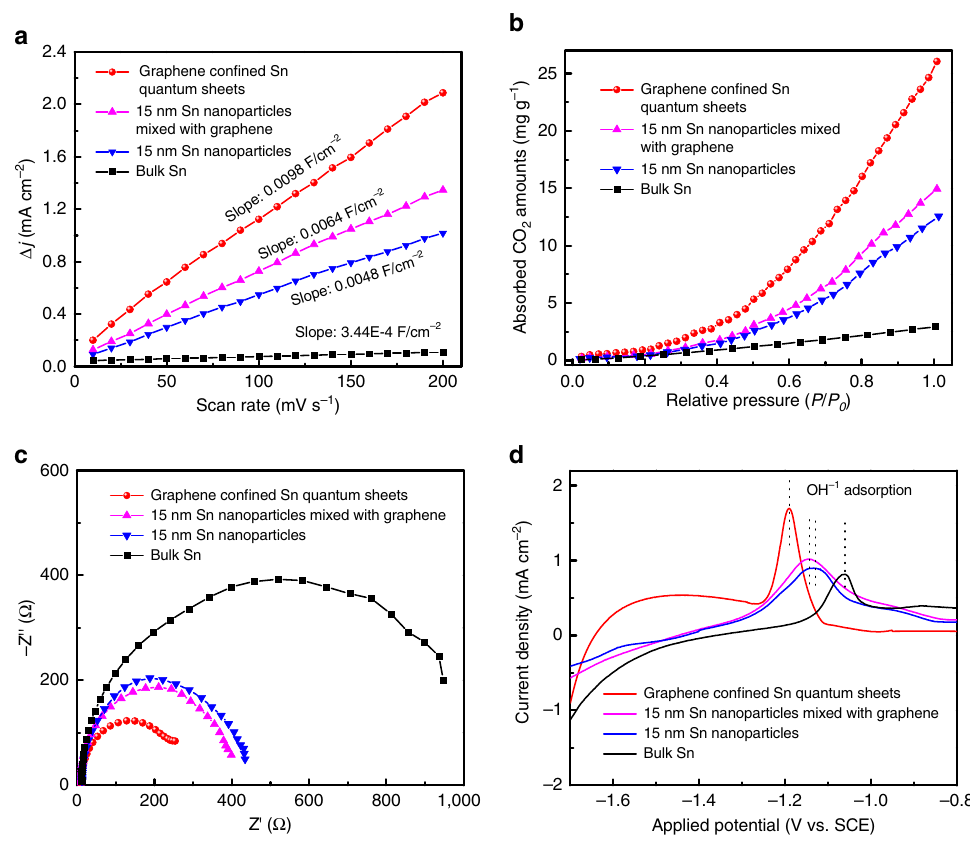
Figure 5 | Advantages of the Sn quantum sheets confined in graphene. ( a ) Charging current density differences plotted against scan rates; ( b ) CO 2 adsorption isotherms; ( c ) Nyquist plots; ( d ) single oxidative LSV scans in N 2 -saturated 0.1M NaOH for the Sn quantum sheets confined in